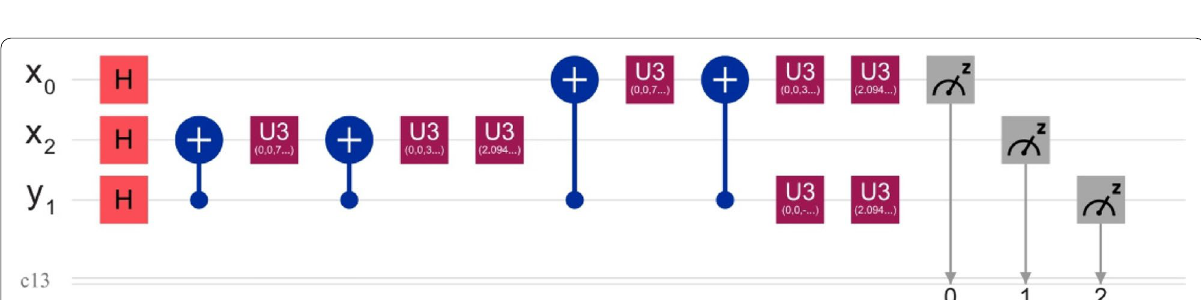
Fig. 4 Example of a quantum circuit for the QUBO expression − 43 y 1 − 240 x 0 − 240 x 2 + 96 y 1 x 0 + 96 y 1 x